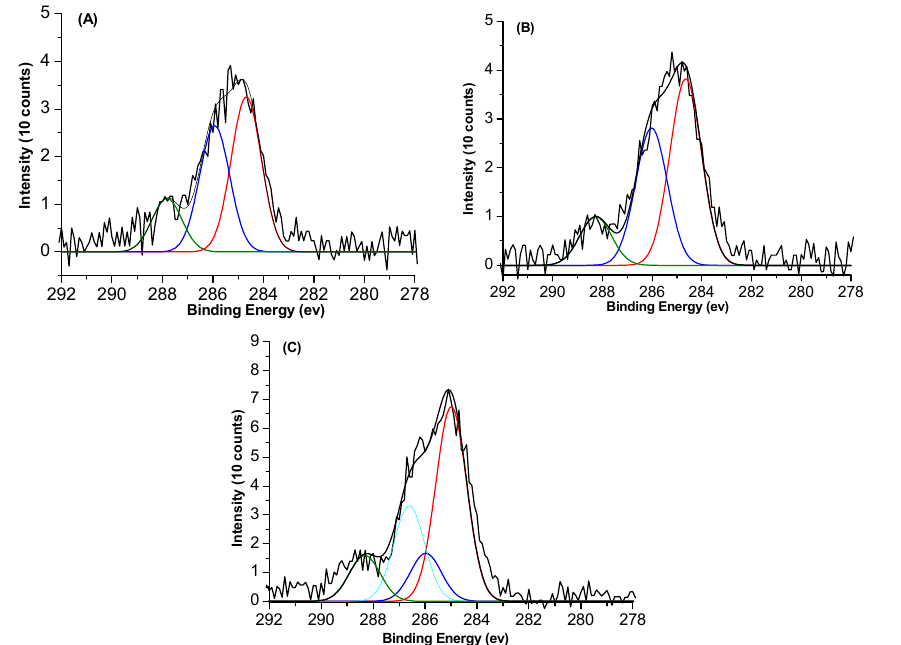
Figure 4. X-ray photoelectron (XPS) high-resolution C1s spectra of ( A ) MSNs–PDEAEMA, ( B ) MSNs–